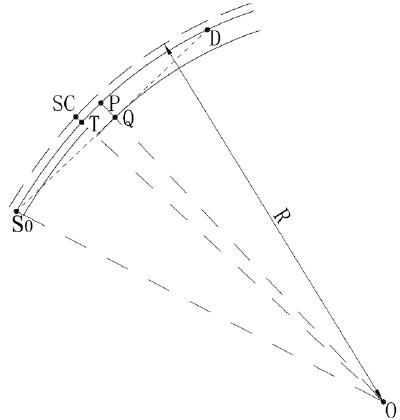
Figure 4. Schematic diagram of horizontal stopping sight distance (S.S.D.) calculation.